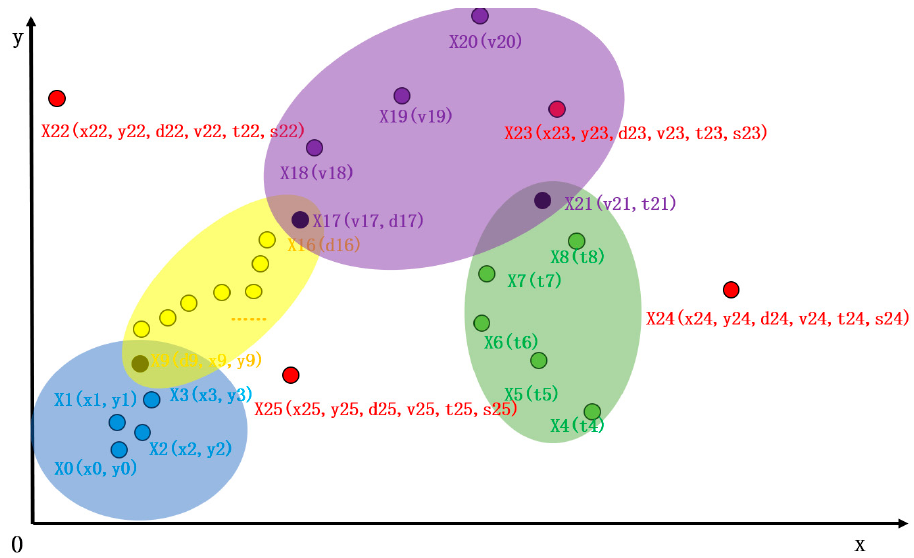
Figure 11. Nonlinear trajectory correction strategy.